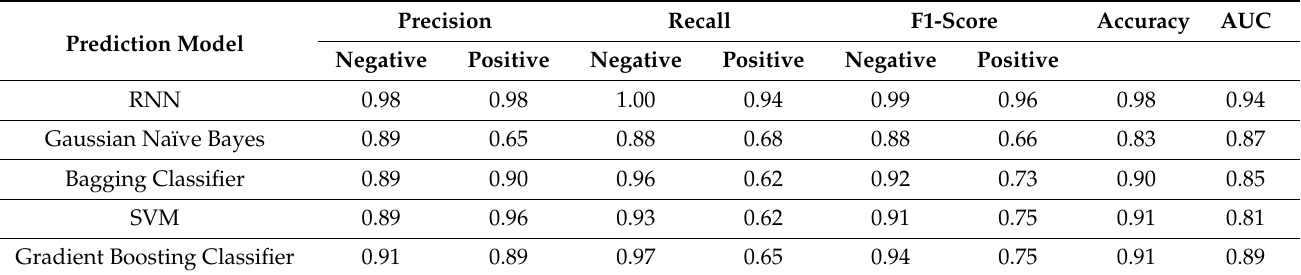
Table 2. Performance of HIV status prediction